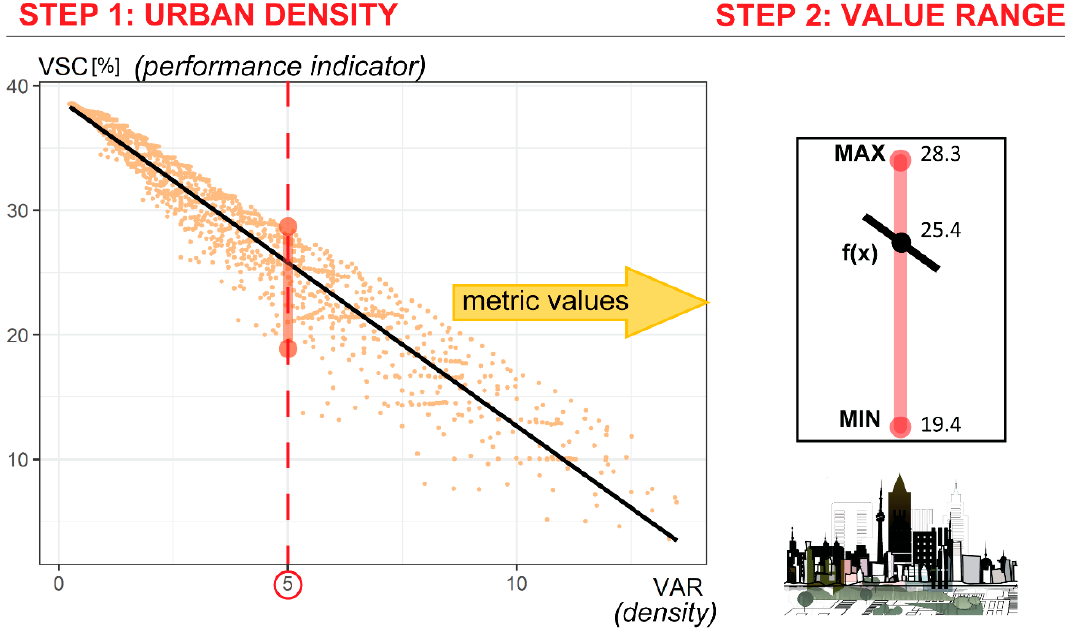
Figure 25. An alternative suggestion for using the metric datasets in solar assessment of neighbour- hood design in urban planning. Assuming target density, the urban planners are presented with the expected ranges of metrics as a reference to compare range values with the results of their designs.